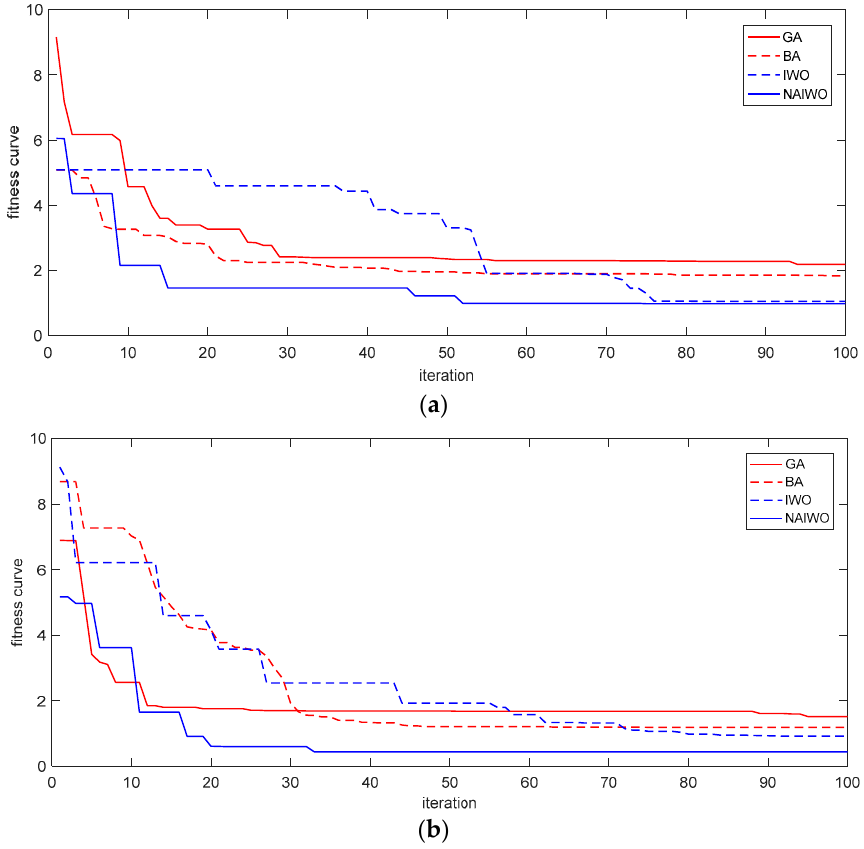
Figure 4. The fitness curves of four algorithms produced during the parameter estimation for ( a ) Pingliang City Wastewater Treatment Plant (PC-WWTP) and ( b ) WC-WWTP.